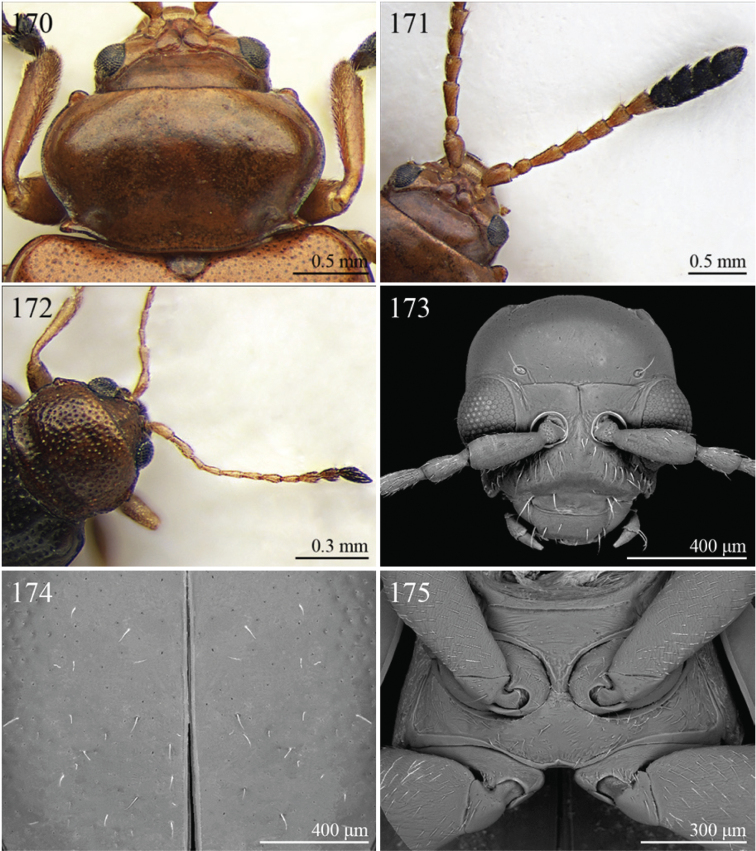
Morphological characters. 170
Diphaulacosoma laevipenne Jacoby, head and pronotum in dorsal view 171 Ditto, head and right antenna in dorsal view 172
Djallonia maindra Bechyné, head, pronotum and right antenna in dorsal view 173
Drakensbergianella rudebecki Biondi & D’Alessandro, head in frontal view 174 Ditto, elytral surface 175 Ditto, meso- and metasternum.